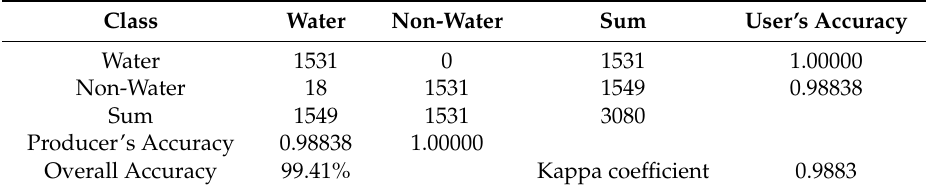
Table 9. Validation statistics of SVM for water body identification.